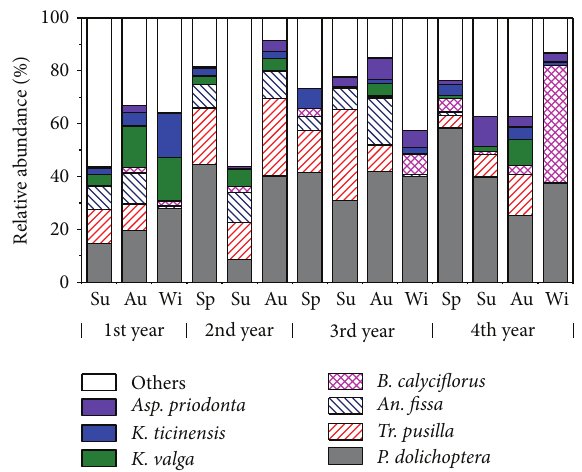
Figure 3: Seasonal variations of the relative abundance of the most representativerotiferspecies(averagerelativeabundance > 3%)from 2006 to 2009 in Dadian Lake (no data recorded during the 2nd winter). Table 2: Results of forward selection and Monte Carlo permutation tests from CCA of rotifer species. Environmental variables are listed by the order of their inclusion in the model ( 𝜆 -A).